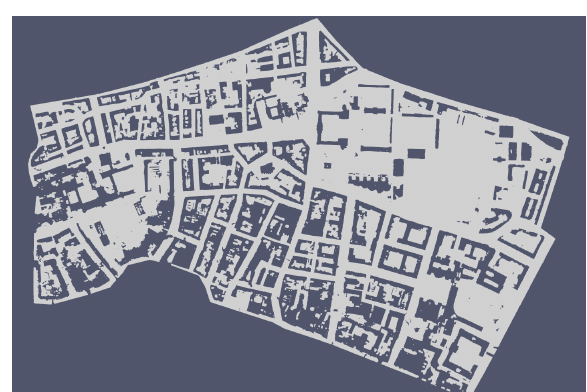
Figure 2. The results of a ground segmenta- tion : The streets are dominating the picture. It can be seen that most of the inner areas of the building were captured as well. The large flat park area in the top right is also